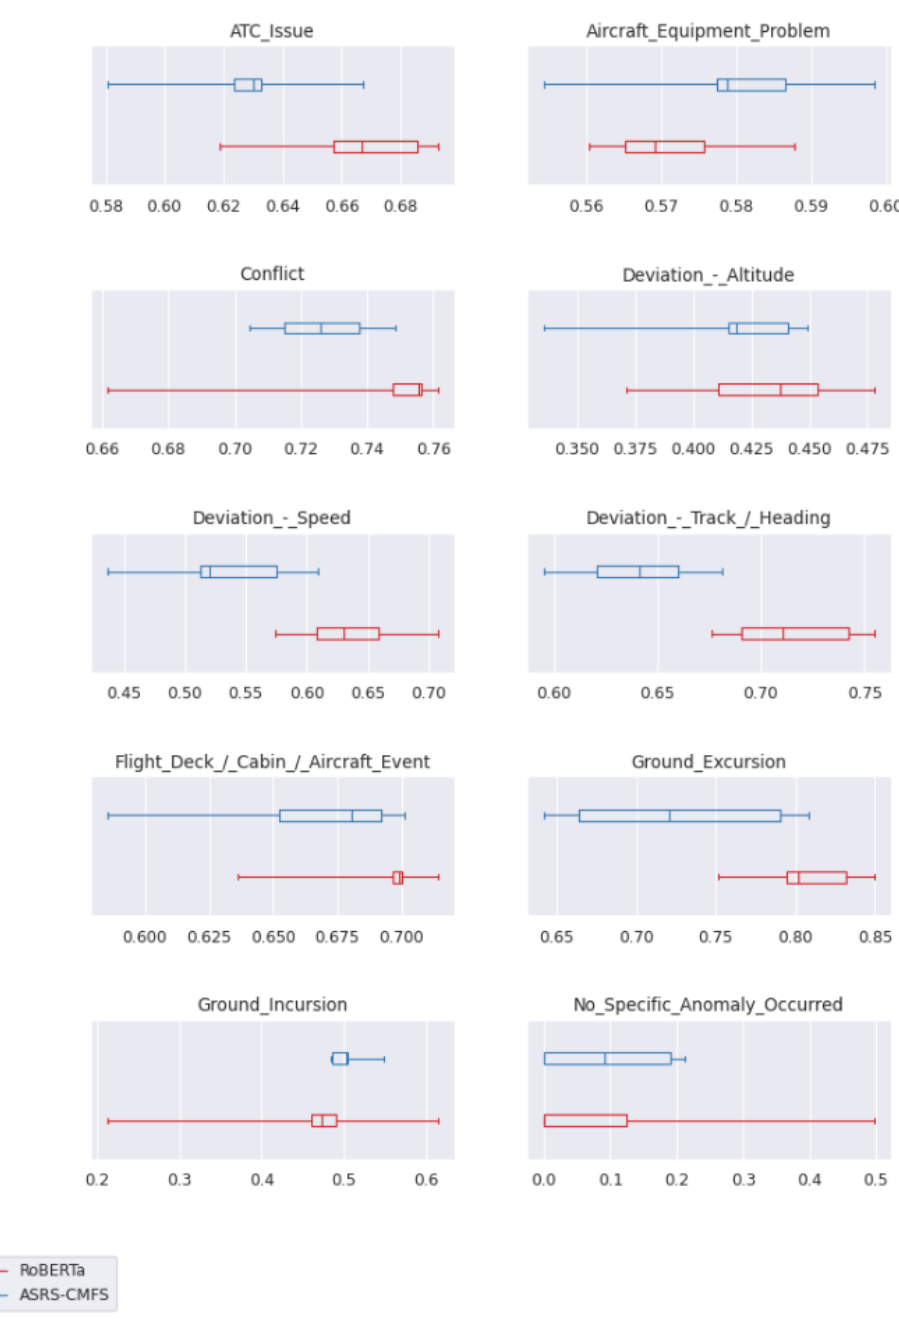
Figure 6. Distributions of the performance scores with overlaps between the two models, across the different text classification